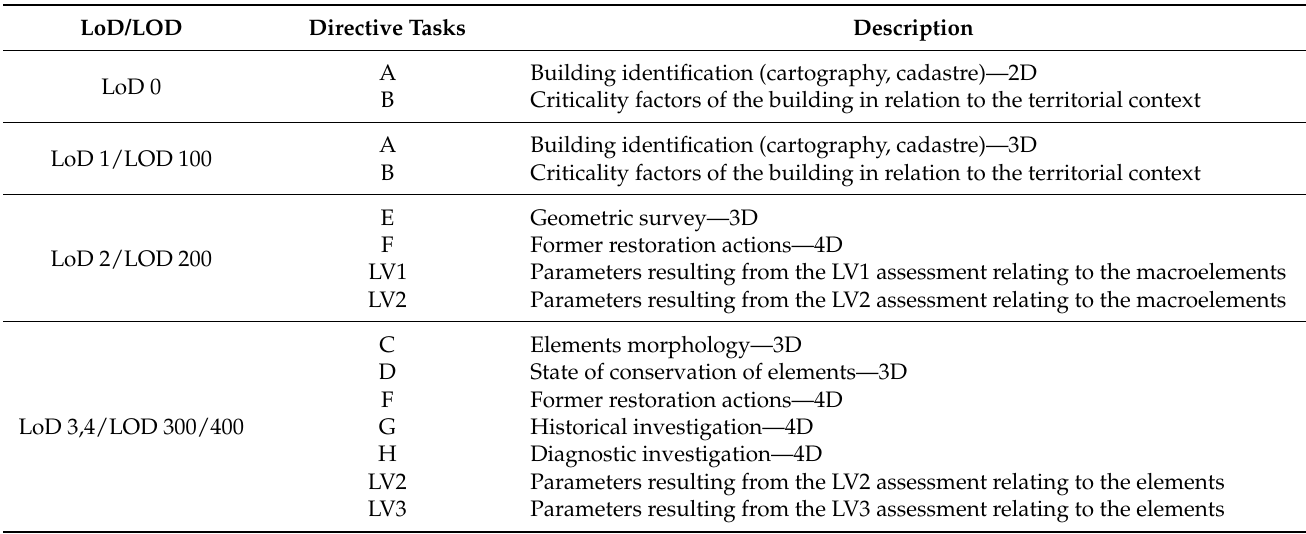
Table 7. Analysis of information needed (for the LoIN definition of the model) through the evaluation of LoD sequence and the punctual directive task, according to DPCM 9/02/2011.